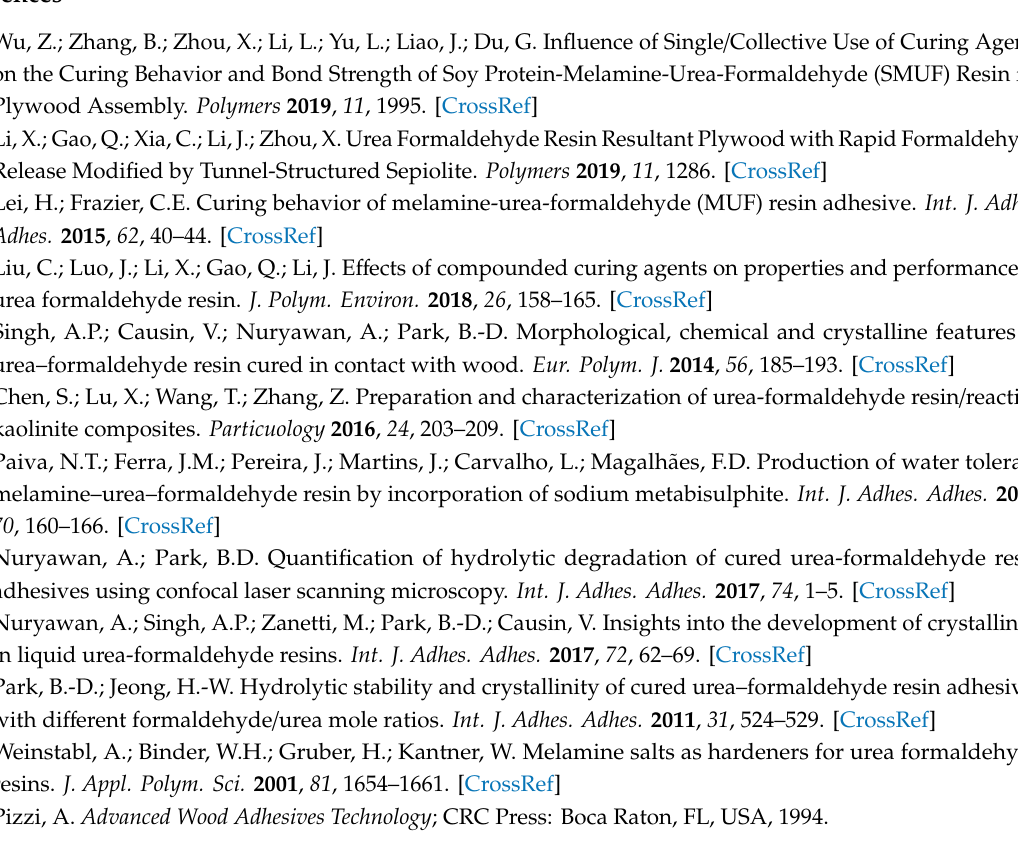
Table S1: TG and DTG results of cured UF resins with di ff erent additives. 13 C NMR Spectra of lignin and modified lignin; Figure S1 13 C NMR spectra of lignin and modified